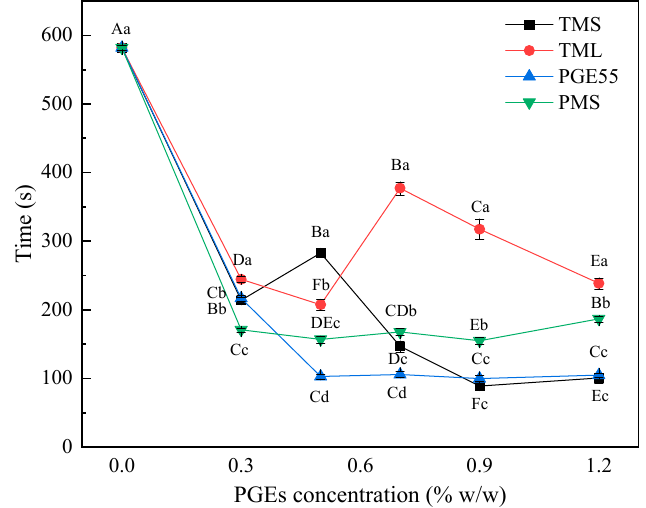
Figure 4. Effect of different PGEs on the whipping time of RDC. Uppercase letters indicate differ- ences between concentrations, and lowercase letters indicate differences between PGEs.